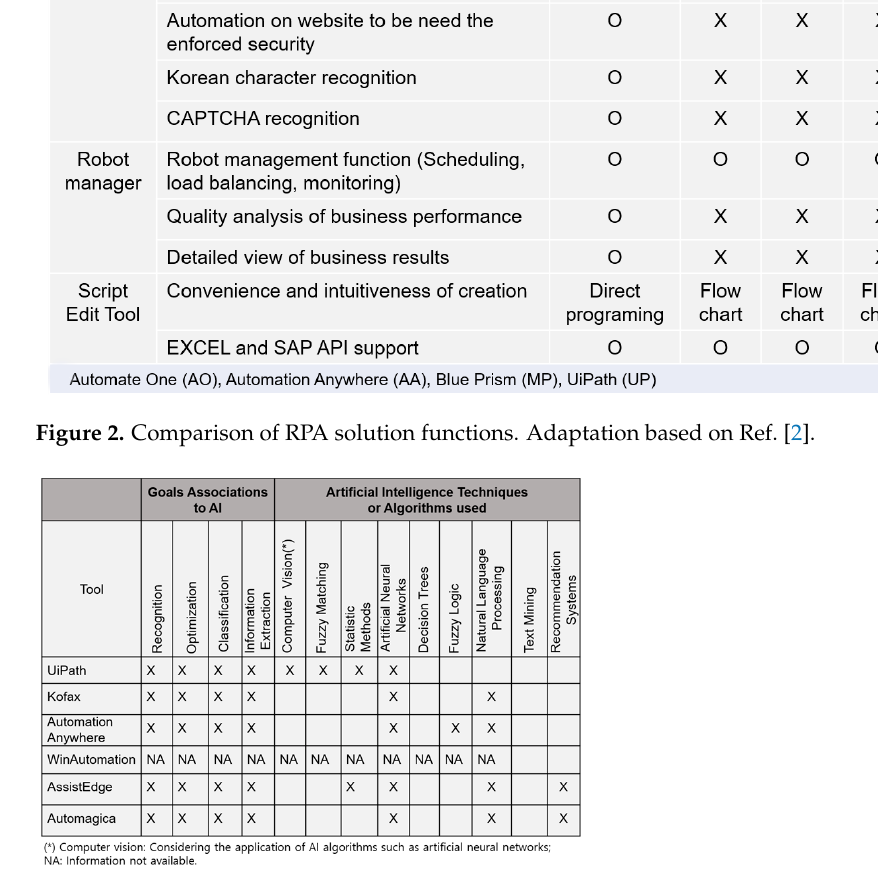
Figure 3. Comparison of technologies and goals associated with AI. Adaptation based on Ref. [4].